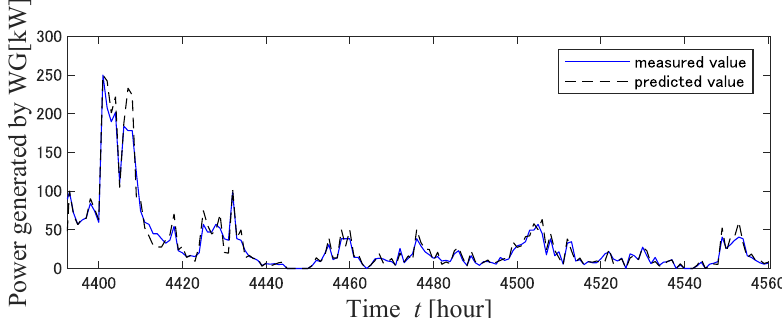
Figure 10. Power generated by WG (autumn).